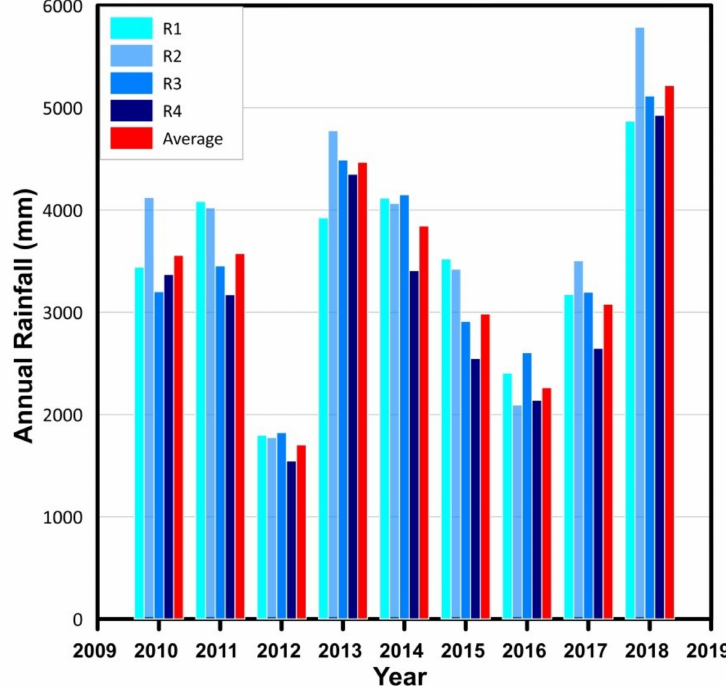
Figure 5. Variation of annual rainfall measured in four rain gauges during the study